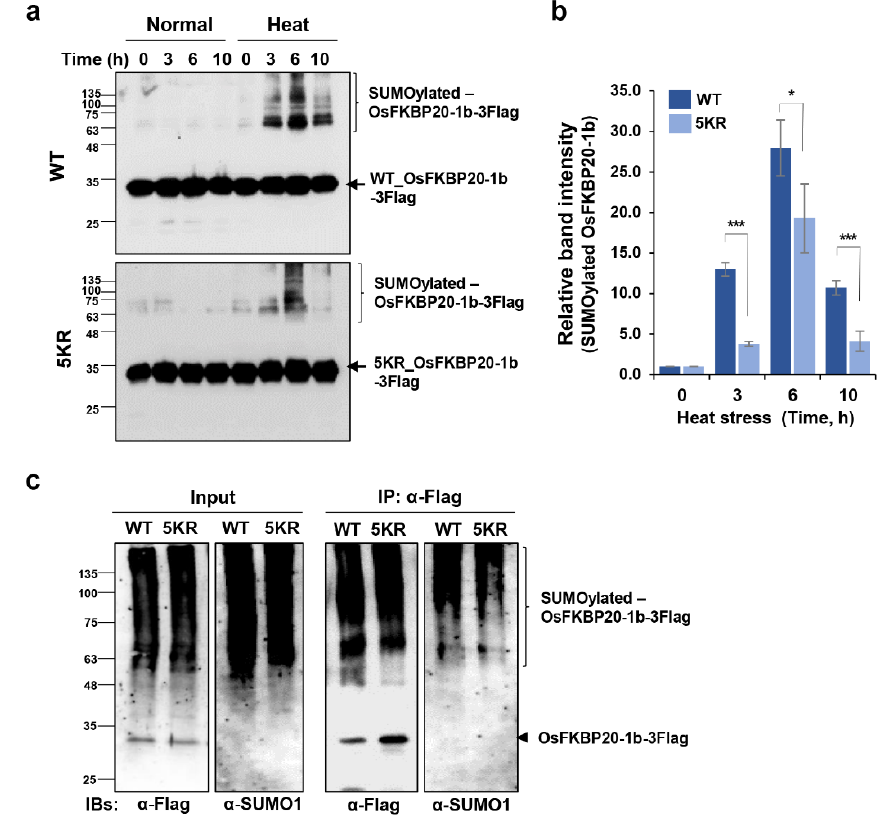
Figure 5. OsFKBP20-1b is SUMOylated by heat stress in planta. Flag tagged WT_ and 5KR_OsFKBP20-1b proteins were transiently expressed in the leaves of 4-week-old N. benthamiana using A. tumefaciens infiltration. Two days after infiltration, plants were treated with 100 μ M CHX and heat stress at 42 °C for 0, 3, 6, 10 h. ( a ) Total proteins were extracted from the leaves and detected by anti-Flag antibody. ( b ) SUMOylated bands were calculated using imageJ program. Error bars represent standard errors from three biological repeat experiments. * p -value < 0.1, *** p -value < 0.01. ( c ) Immuno-precipitation assay of OsFKBP20-1b under heat stress. Two days after infiltration, plants were treated with 100 μ M CHX and heat stress at 42 °C for 3 h. After nuclear protein fractionation, OsFKBP20-1b-Flag proteins were precipitated using anti-Flag bead and detected by anti-Flag or anti-SUMO antibody.